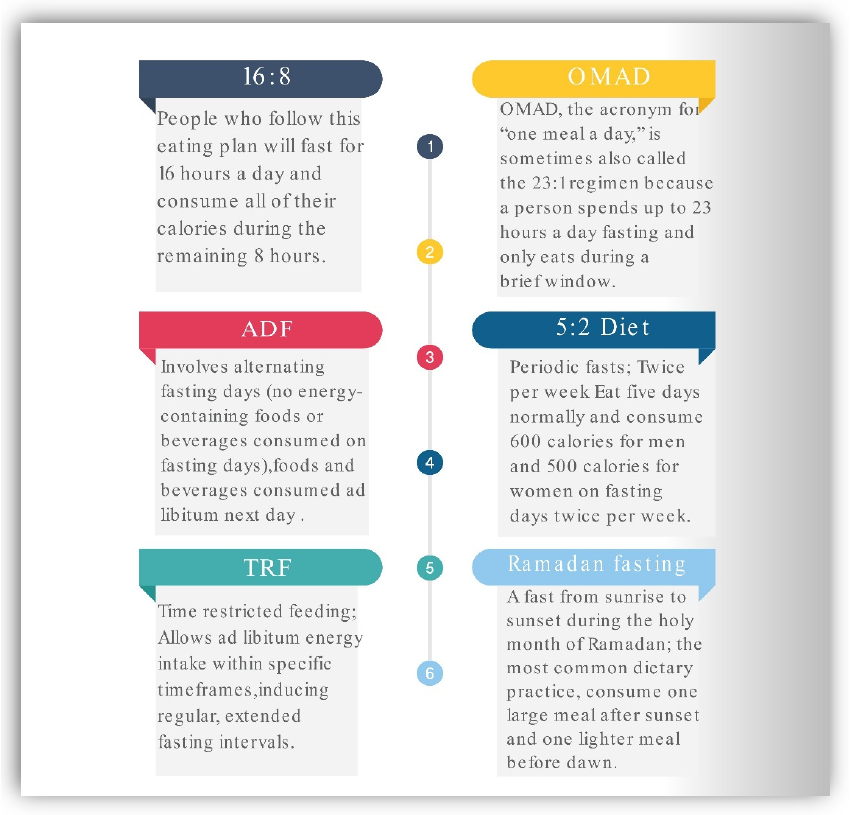
Figure 1. Most common Intermittent fasting regimens. ADF—Alternate-day fasting, TRF—Time restricted feeding, OMAD—one meal a day.